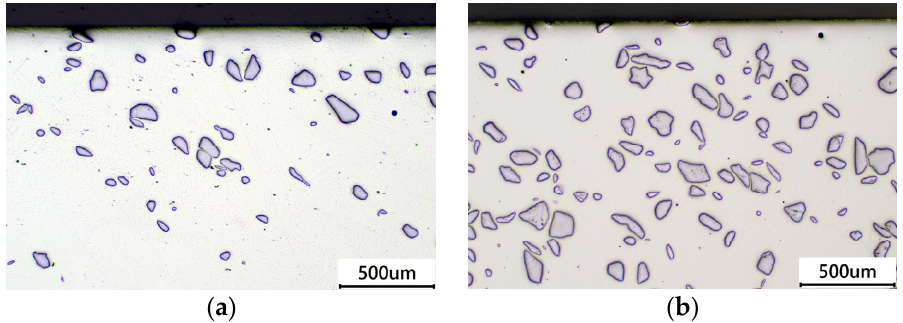
Figure 1. Cross-sectional micrographs of the as-deposited AISI 316 L steel-based WC composite layers with various WC compositions: ( a ) WC 20 wt.%, and ( b ) WC 40 wt.%.